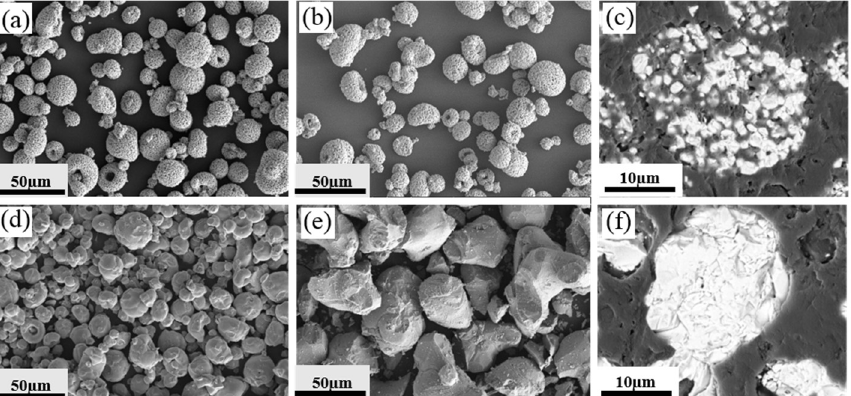
Figure 6. The morphology of Cu 0.3 Mn 1.5 − x Co 1.5 − y O 4 powders sintered at: ( a ) 900 ◦ C for 12 h; ( b ) 1000 ◦ C for 12 h; ( c ) 1000 ◦ C for 12 h (cross-sectional); ( d ) 1100 ◦ C for 4 h; ( e ) 1300 ◦ C for 4 h; ( f ) 1100 ◦ C for 4 h (cross-sectional).